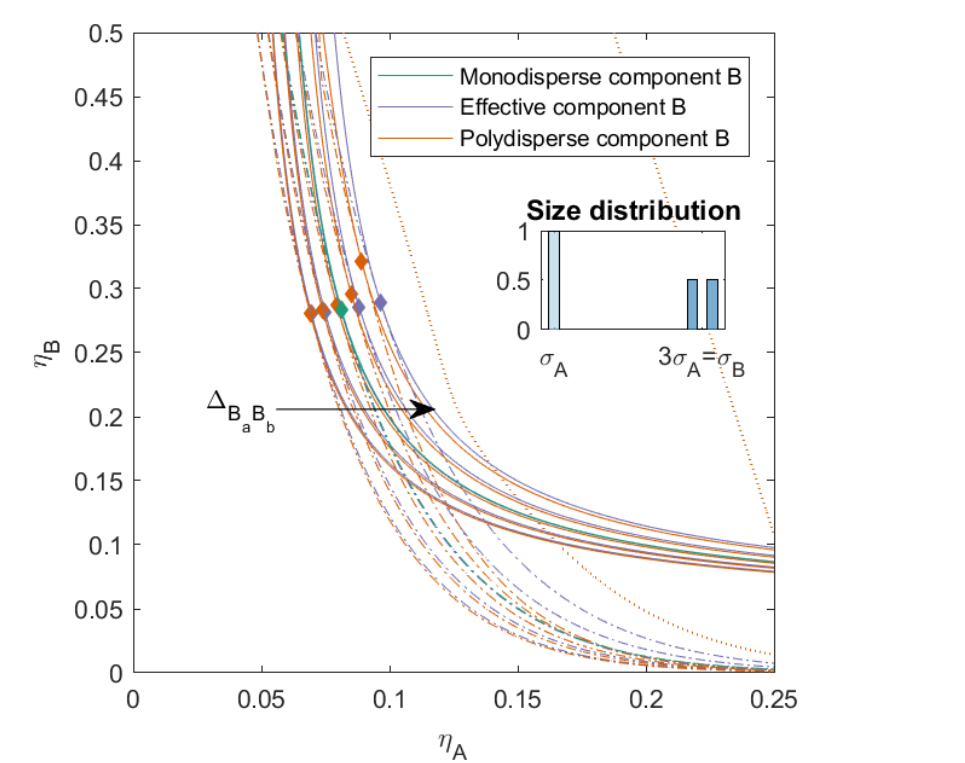
Figure 7. Phase diagram for binary (component A and B ) nonadditive hard sphere mixture with size ratio q = σ A / σ B = 1/3 plotted as a function of the partial packing fractions, η A and η B ; component A is monodisperse, component B is polydisperse ( PD = 4.00). The symbols σ A and σ B refer to the diameters of the species A and B, respectively. The interaction between components A and B is nonadditive with a nonadditivity parameter ∆ AB = 0.075, the interaction between the subcomponents B is nonadditive, the nonadditivity parameter ∆ B was varied from − 0.1 to 0.1 with a step size of a B b 0.05 (the arrow indicates increasing ∆ B ). The spinodal (solid line) and binodal (dashed line) meet a B b each other at the plait point (diamond), the three-phase boundary is indicated with a dotted